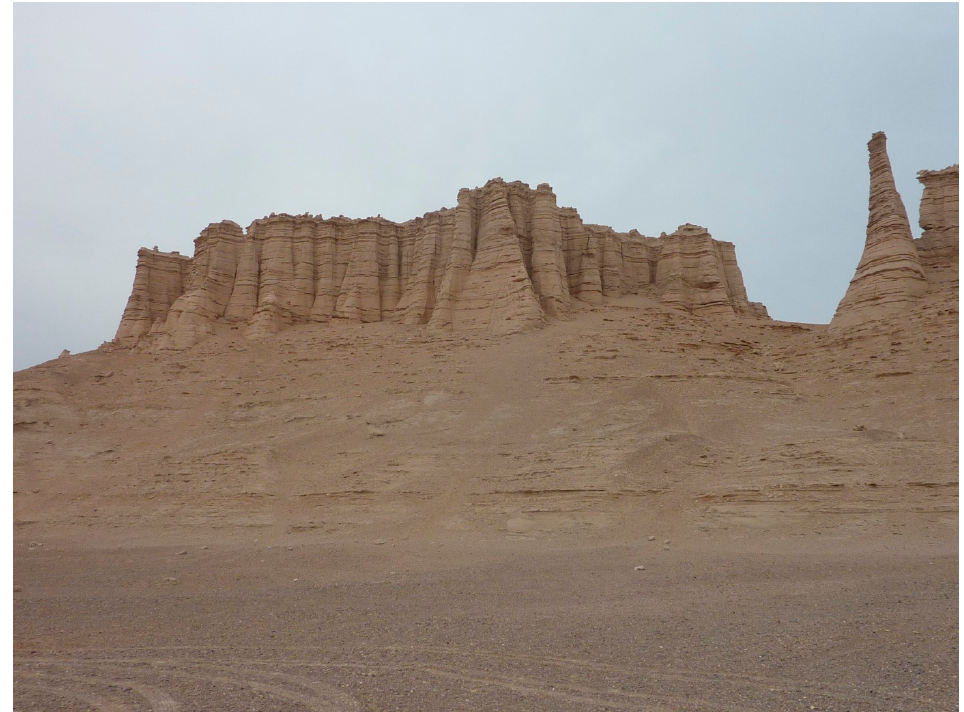
Figure 4. Yardangs in the so-called Devils City, west of Hami, Xinjiang, China (photo: Ch. Opp).